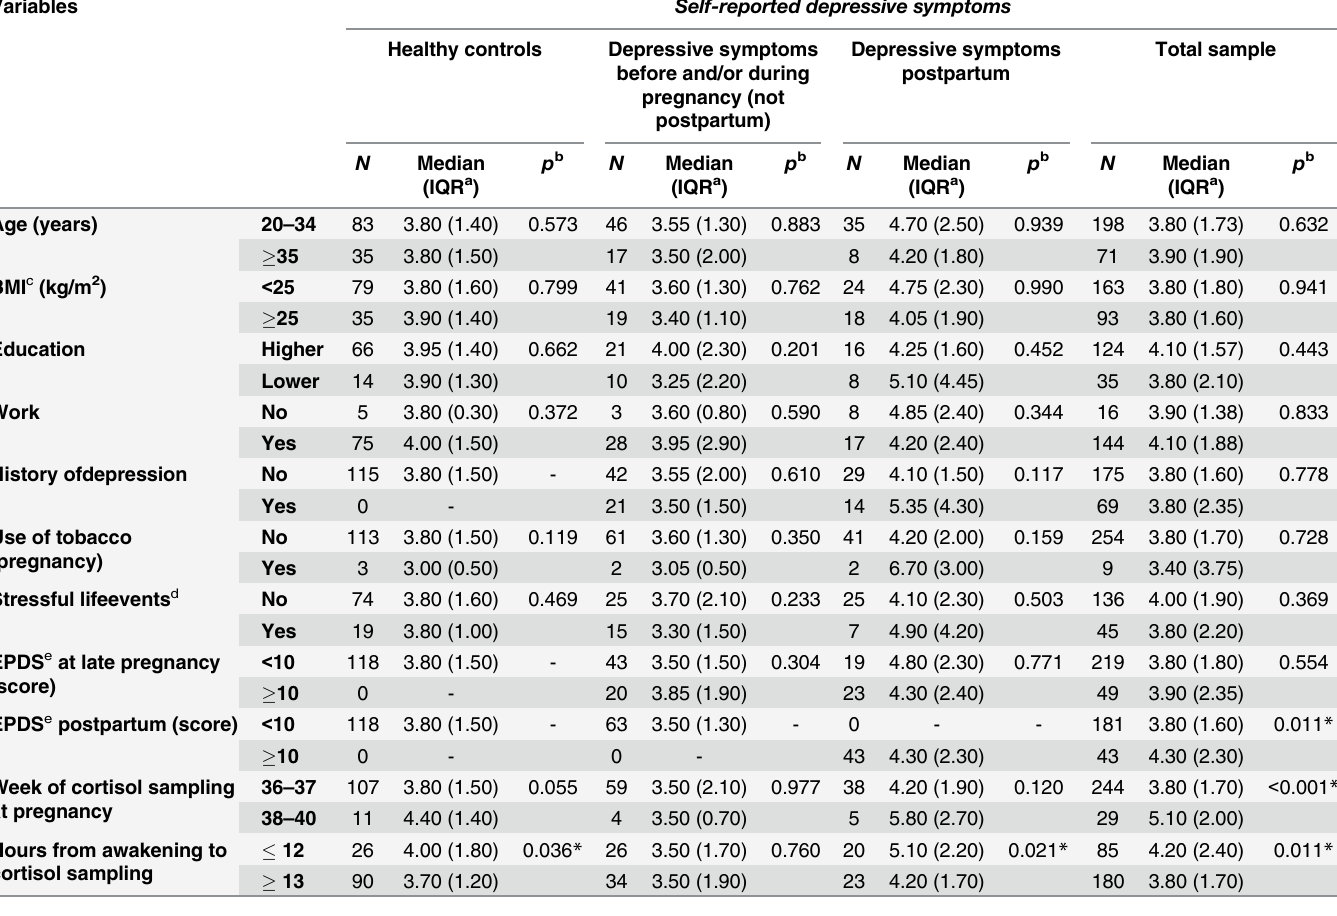
Table 2. Anthropometric, lifestyle, obstetric and psychiatric characteristics in relation to evening salivary cortisol levels (nmol/L) at late preg- nancy stratified by self-reported depressive symptoms. Variables Self-reported depressive symptoms Healthy controls Depressive symptoms Depressive symptoms before and/or during pregnancy (not postpartum)